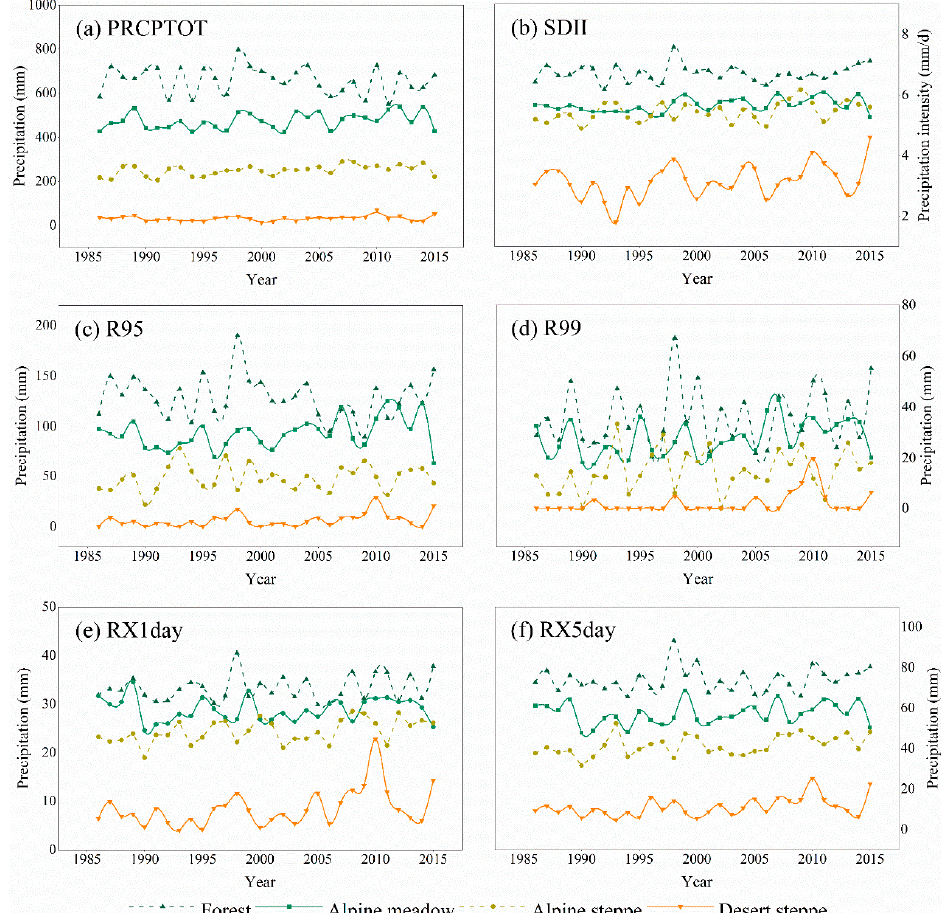
Figure 7. Temporal pattern of precipitation in different ecosystems of the Tibetan Plateau. Graphs represent ( a ) interannual variation of PRCPTOT, ( b ) SDII, ( c ) R95, ( d ) R99, ( e ) RX1day, and ( f ) RX5day.